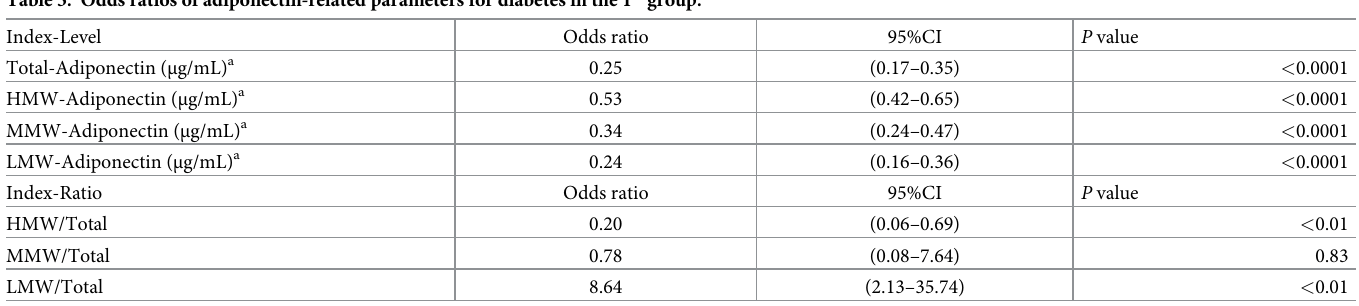
Table 5. Odds ratios of adiponectin-related parameters for diabetes in the 1 st group.